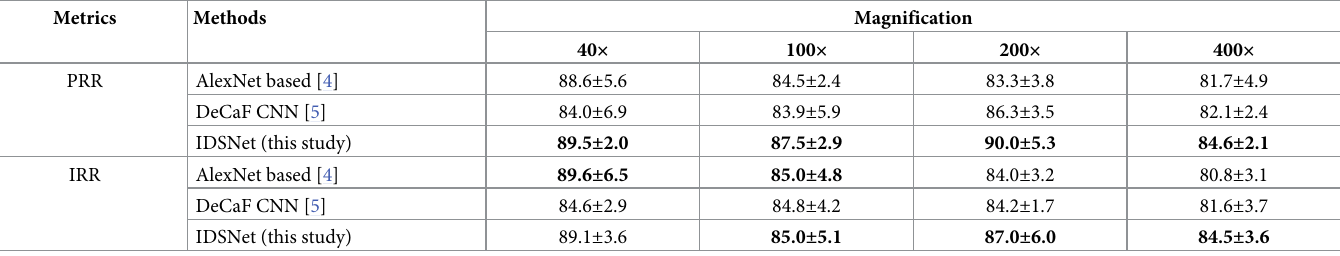
Table 4. Performance of BC classification for the proposed IDSNet in comparison with other literature methods. The best performance is highlighted by boldface. Metrics